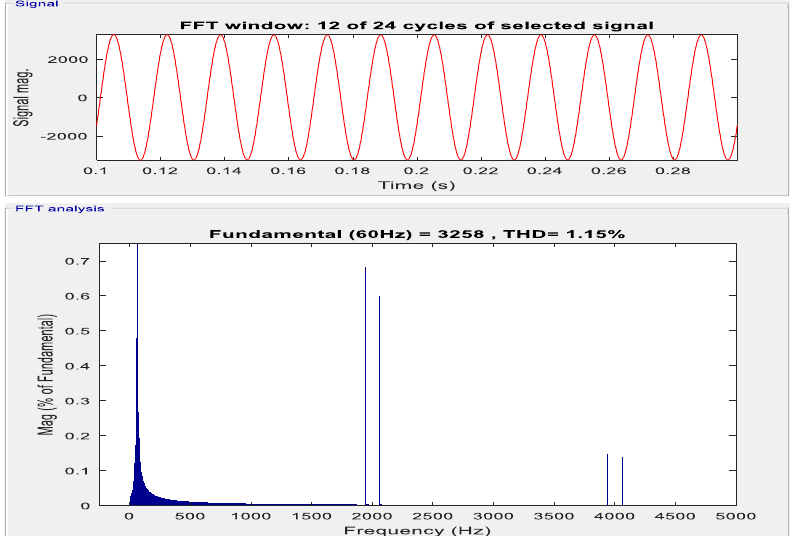
Figure 14. Total harmonic distribution (THD) analysis of inverter-injected current